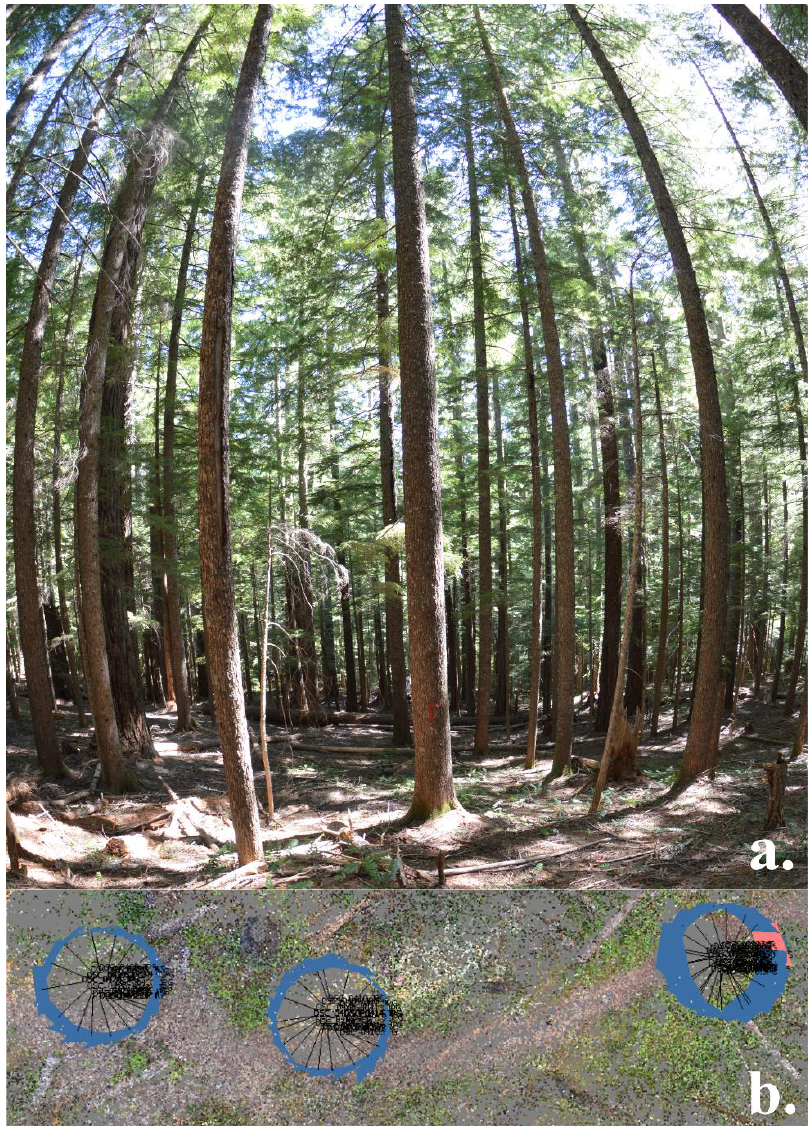
Figure 3. ( a ) Raw image captured with the Sigma EX 10 mm Fisheye lens mounted on the Nikon D3200 camera used to generate the below canopy point cloud. ( b ) Nadir view of the aligned and merged tie points build from three locations along a path where images where captured; the blue rectangles are the relative position of the sensor, the orange is the position of the above image, and the black lines shows the direction faced by the sensor (outward).